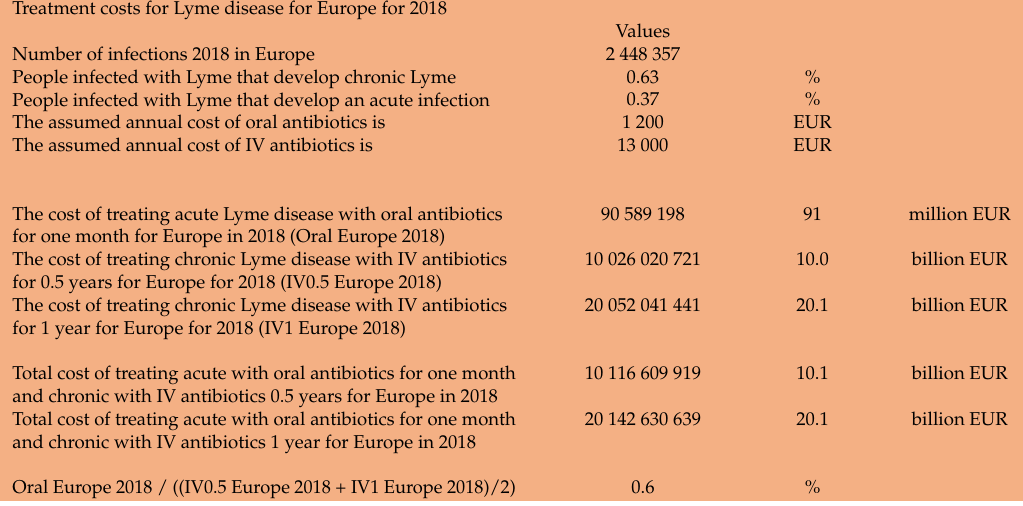
Table 12. The estimated total cost for the treatment of acute and chronic Lyme disease for Europe for